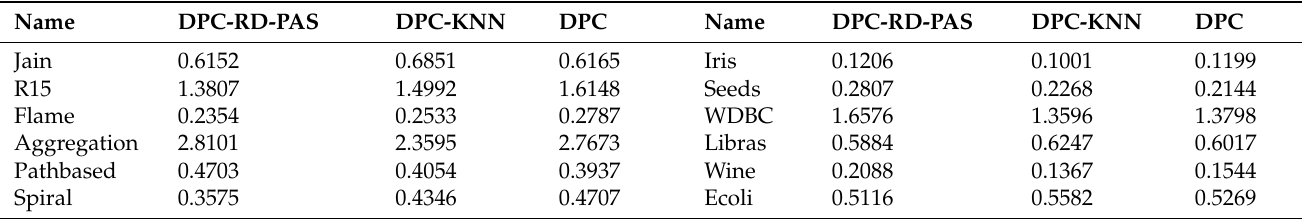
Table 5. Running time of three density peak clustering algorithms (Unit: